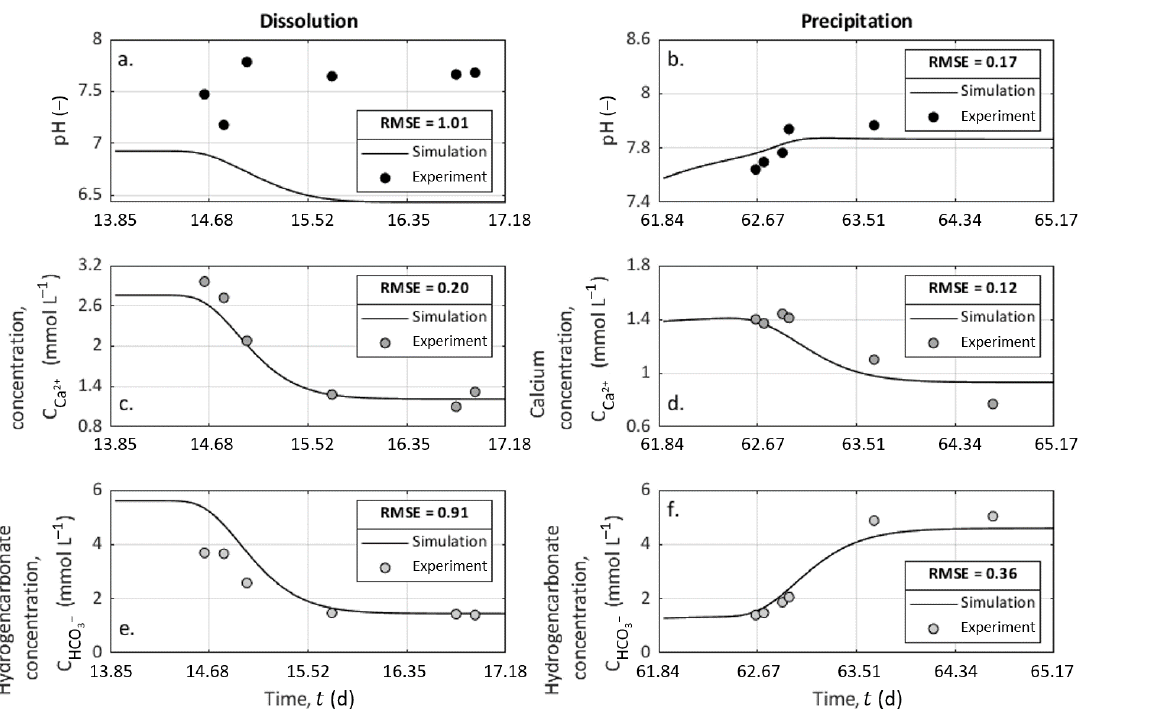
Figure 7. Measured and modeled pH, calcium concentration, and bicarbonate concentration. The data points come from the chemical analyses conducted on the outlet pore water samples, and the curves are obtained from CrunchFlow simulations. ( a , c , e ) Comparison between the measured data and the corresponding simulations for dissolution. ( b , d , f ) Comparison between the measured data and the corresponding simulations for